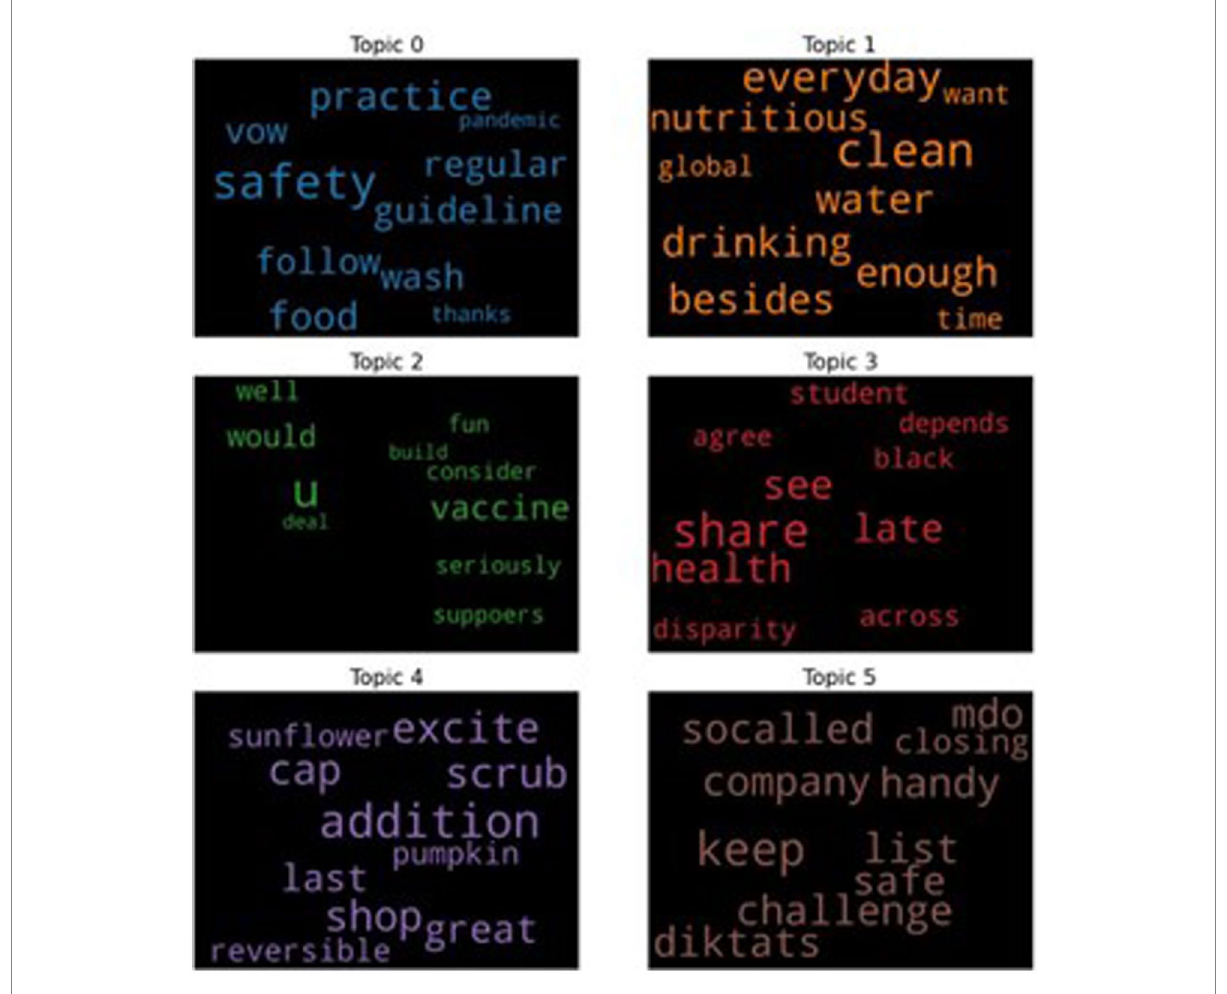
FIGURE 8 The top six topics for the tweets with the positive